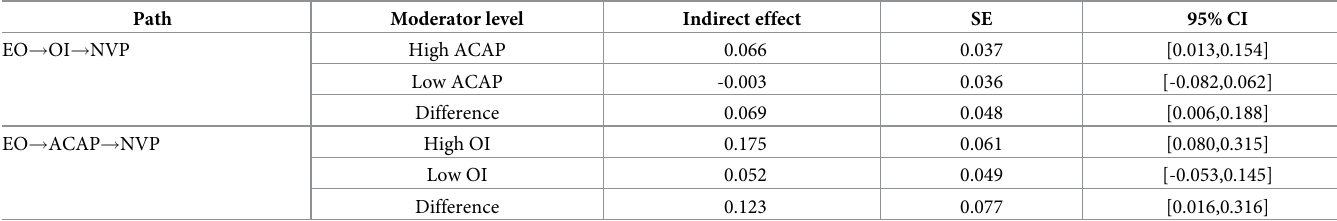
Table 6. Results of the conditional indirect